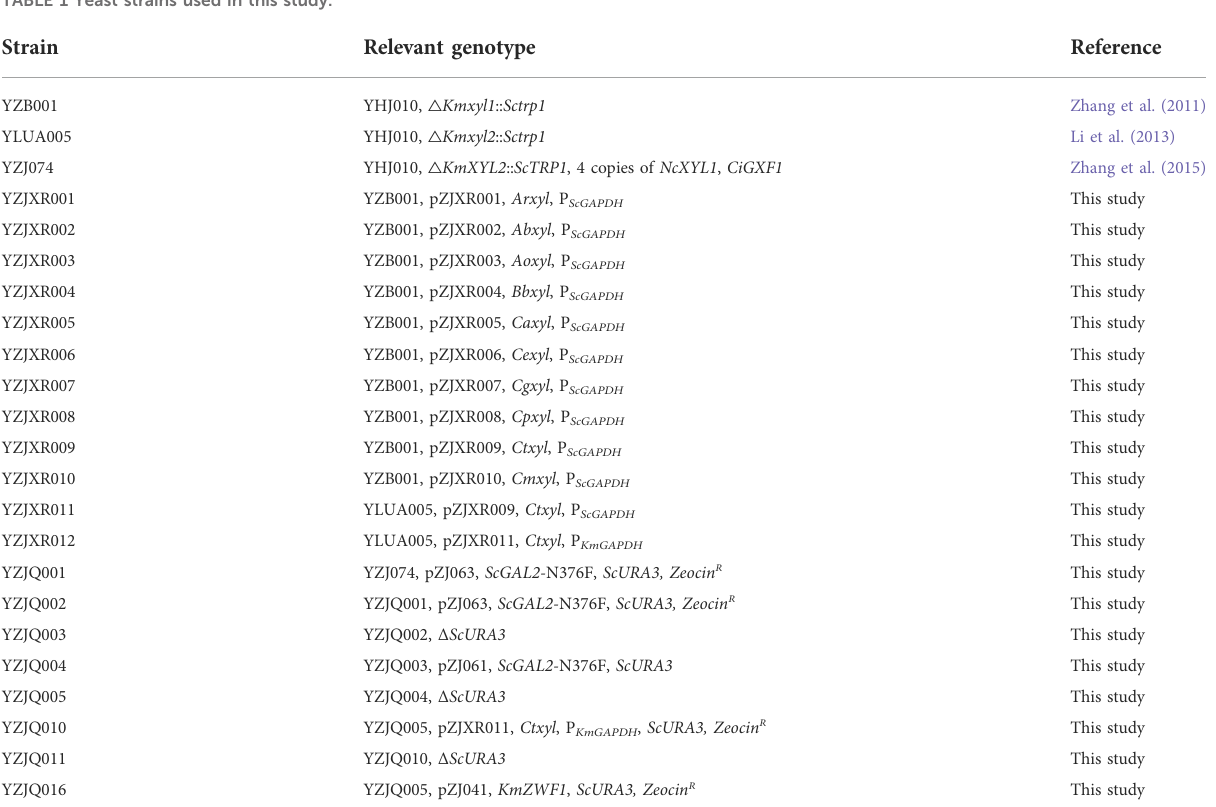
TABLE 1 Yeast strains used in this